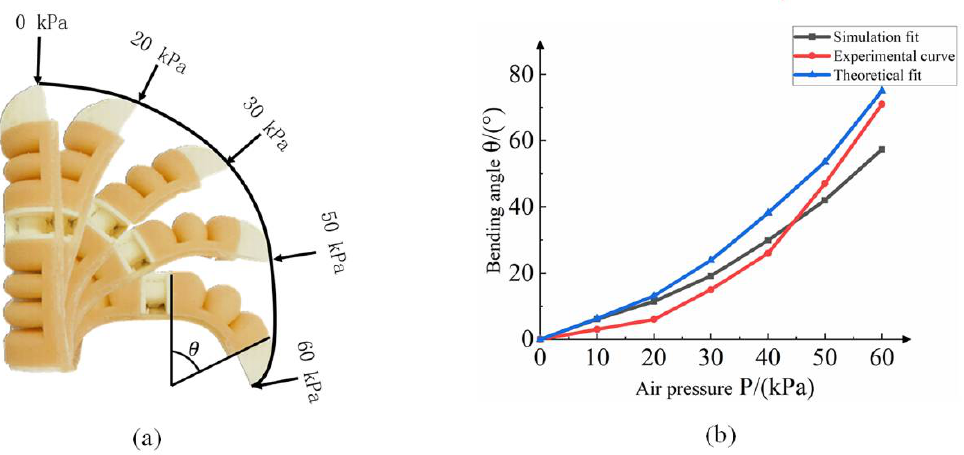
Figure 15. ( a ) Bending deformation state of fingers under different loads; ( b ) bending angle comparison curve after correction.